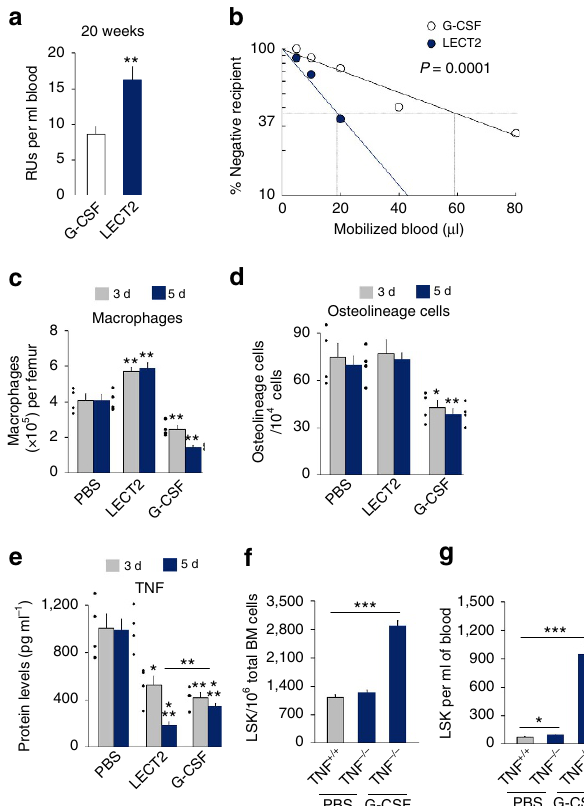
Figure 9 | G-CSF and LECT2 exhibit different effects on mobilization of RU and CRU, BM cells and TNF expression. ( a ) RU based on donor chimaerism determined by flow cytometry in peripheral blood 20 weeks after competitive transplantation with blood from 5-day LECT2- or G-CSF- treated mice; n ¼ 5. ( b ) CRU frequency in LECT2 or G-CSF mobilized blood was compared by limiting dilution transplantation assays. Engraftment levels of CD45.2 cells were quantified 20 weeks after transplantation; mice with 4 1% CD45.1 cells were considered positive for mobilized blood engraftment. Dose-dependent engraftment derived from mobilized blood was observed. The CRU frequency was 52.9ml (cid:2) 1 for LECT2 mobilized blood, 16.9ml (cid:2) 1 for G-CSF mobilized blood; n ¼ 15 each point. ( c ) The number of macrophages after G-CSF or LECT2 injection. The macrophages were F4/80 þ CD169 þ cells; n ¼ 4. ( d ) The number of osteolineage cells after G-CSF or LECT2 injection. PBS and G-CSF, n ¼ 4; LECT2, n ¼ 6. The osteolineage cells were CD45 (cid:2) Ter119 (cid:2) CD31 (cid:2) Sca-1 (cid:2) CD51 þ cells isolated from BM. ( e ) TNF expression after G-CSF or LECT2 injection. 3 d, n ¼ 4; 5 d: PBS, n ¼ 4; LECT2, n ¼ 8; G-CSF, n ¼ 8. ( f , g ) The effect of G-CSF on the expansion and mobilization of LSK cells in TNF KO mice; n ¼ 5. The small black dots in histograms are data points. The data represent means ± s.e.m. The data are representative of two ( a , b , f , g ) and three ( c – e ) independent experiments. * P o 0.05, ** P o 0.01, *** P o 0.001 using one-way ANOVA ( a , c – g ) and Poisson’s statistic ( b